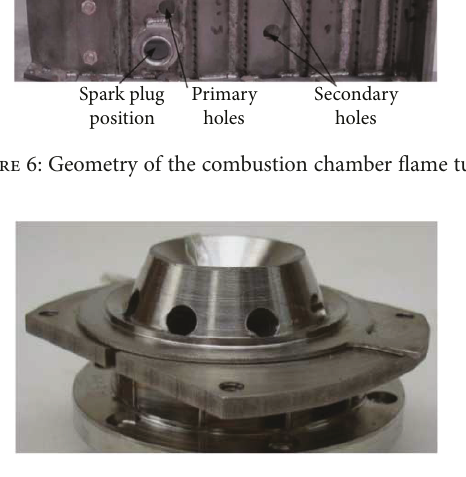
Figure 7: The swirl cup.